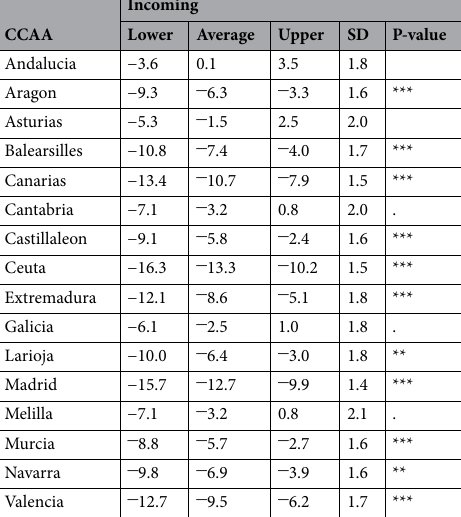
Table 6. Bayesian structural time series estimates: the table can be analysed (using Madrid) that the reduction in trips in Cataluña fell by 12.7% with a confidence interval of (− 15.7%, − 9.9%) which is statistically significant at the 0.1% level. These findings are consistent with the results found in the difference-in-difference internal column of Table 5. All values in %. 1 *** 0.1%, ** 1%, * 5%, . 10% significance